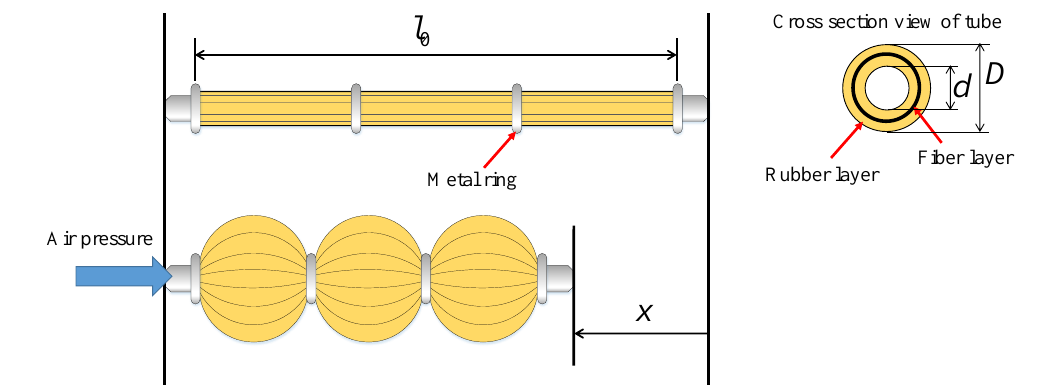
Figure 2. The schematic of the straight-fiber artificial muscle (SFPAM).